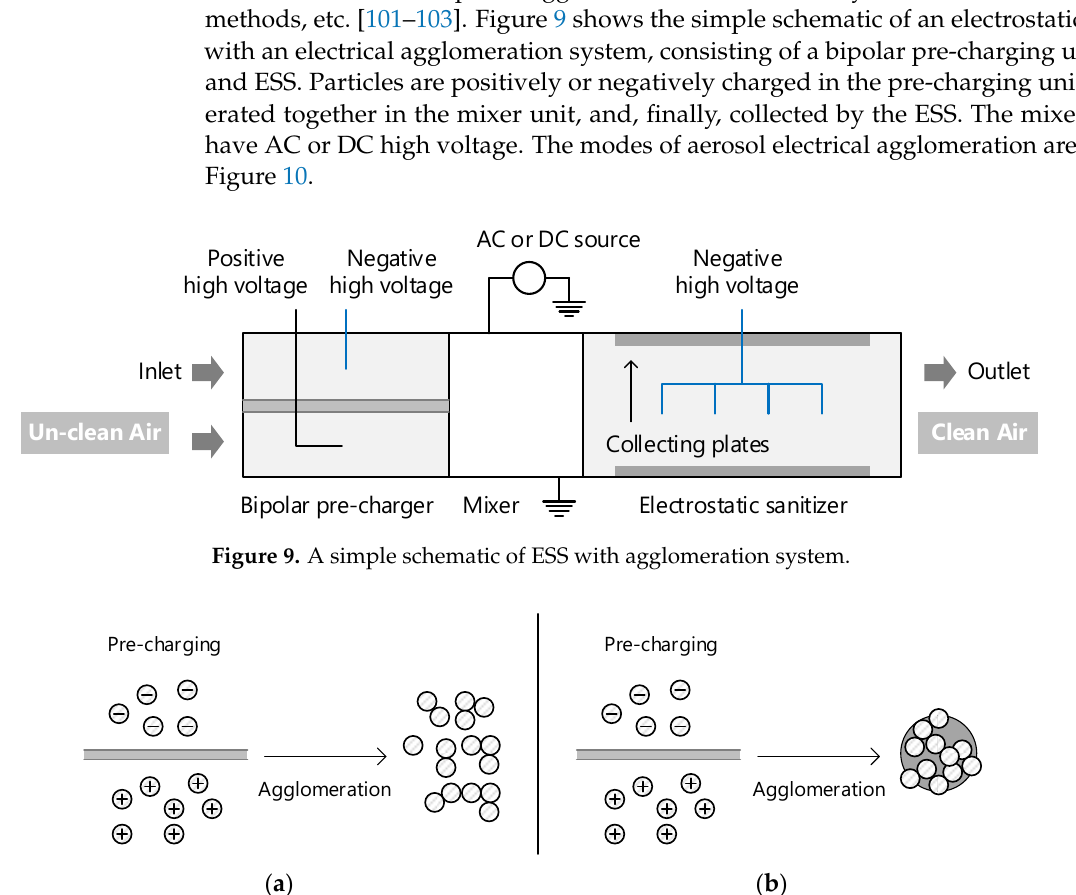
Figure 10. Aerosols electrical agglomeration; ( a ) agglomeration of small particles together; ( b ) agglomeration of small particles with the large particle.